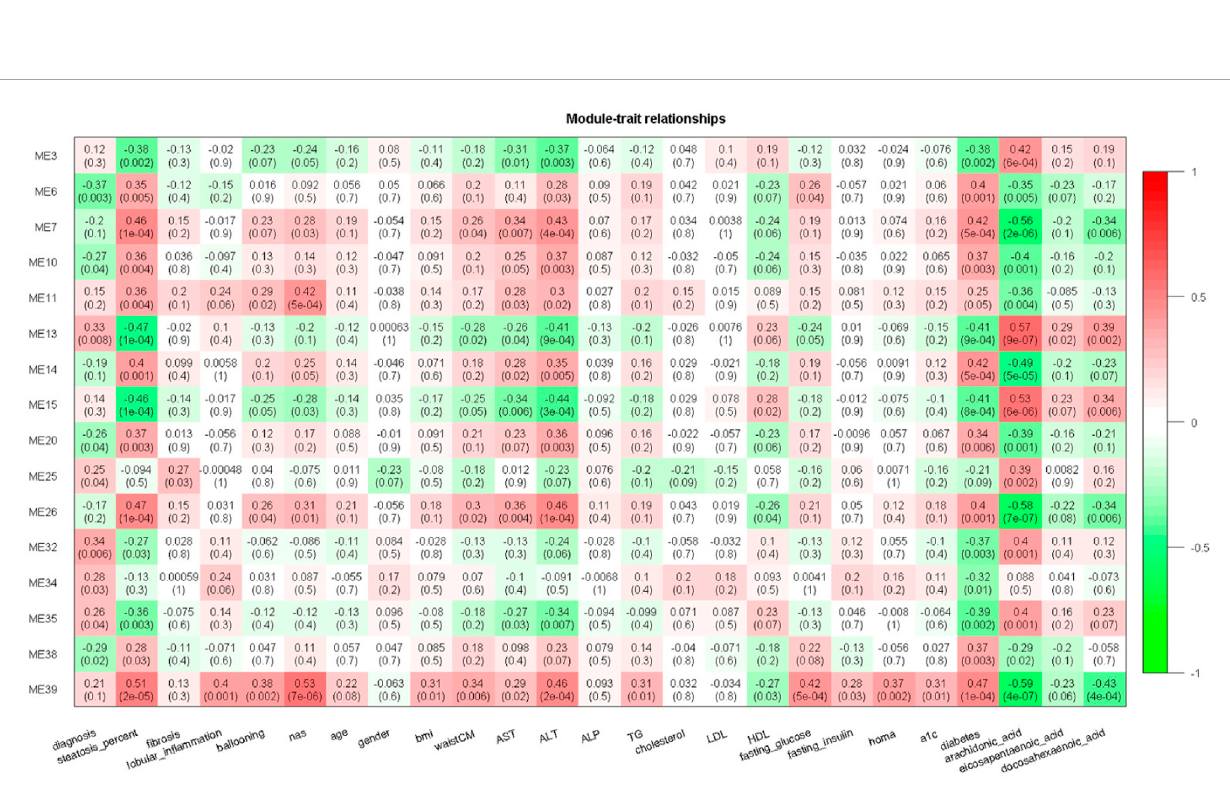
FIGURE 4 Module-trait relationship heatmap for GSE89632. Cells represent the correlation between modules expressionand clinical parameters. Numbers in the bracket indicate the statistical signi fi